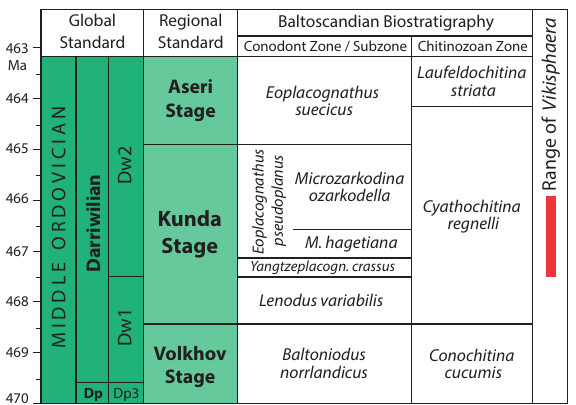
Fig. 2. Stratigraphic background and temporal distribution of Vikisphaera kundana gen. et sp. nov. Regular time scale after Lindskog et al. (2017). Dp,